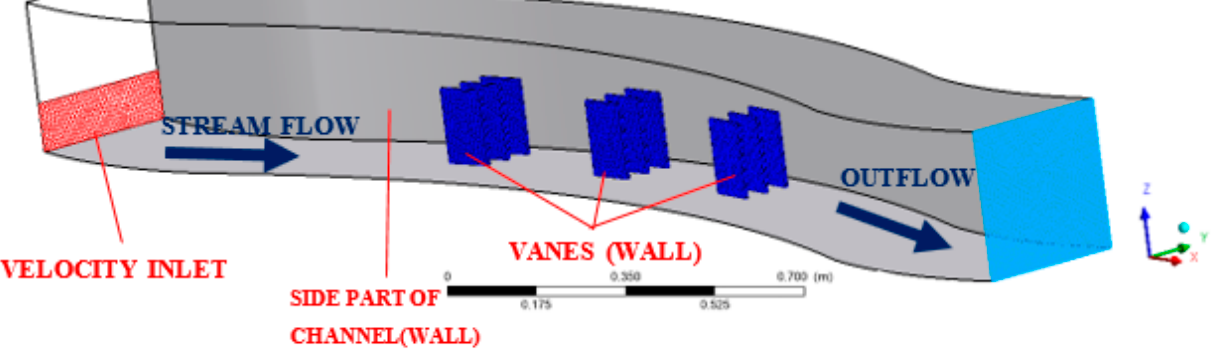
Figure 4. Boundary conditions for “with vanes” situation according to the downstream view.